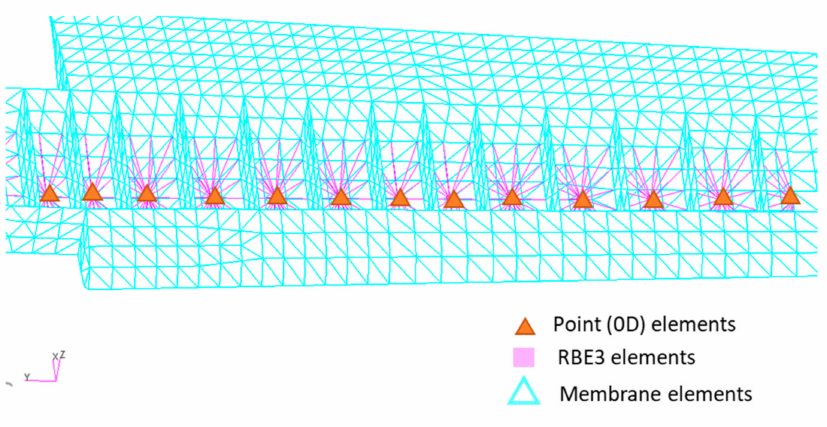
Figure 5. Modeling of inertia loads of a lateral